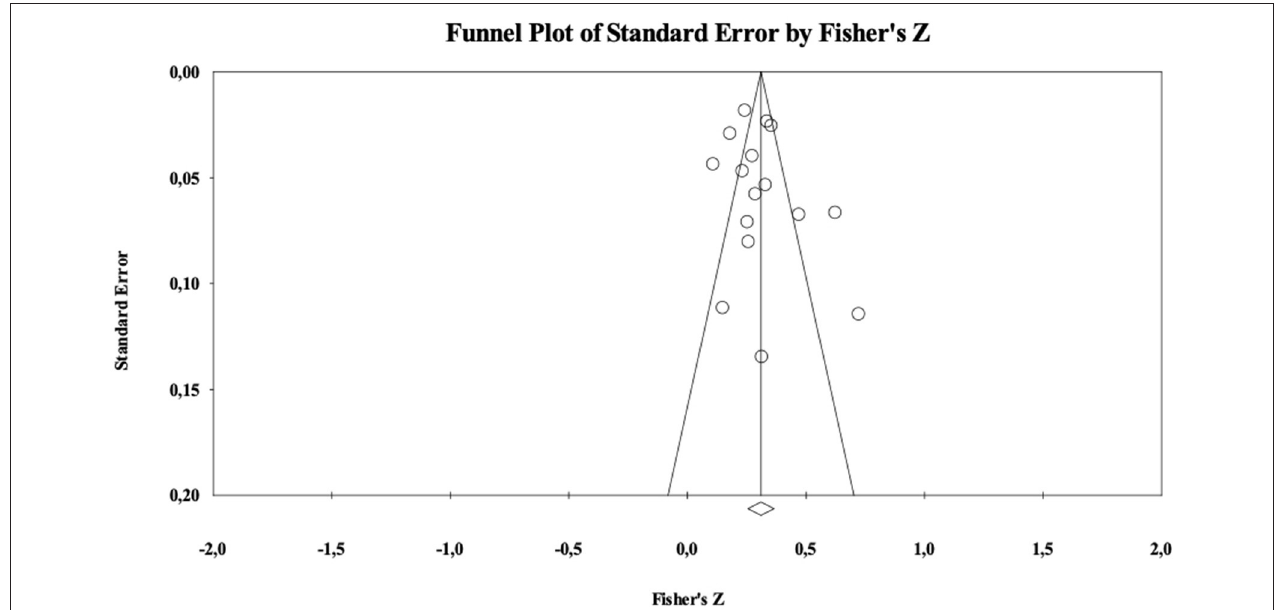
FIGURE 3 | Funnel plot for intentions.